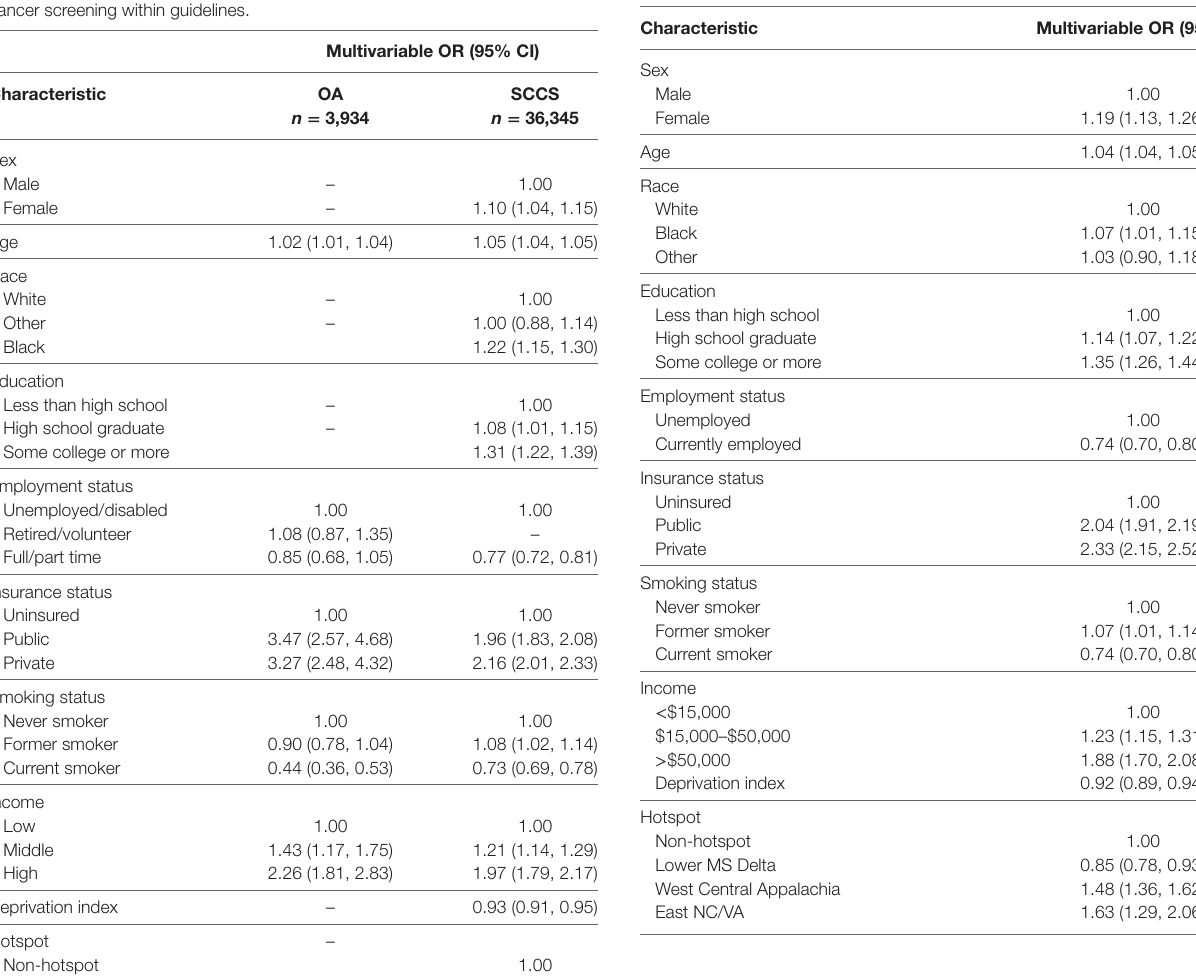
TaBle 3 | Southern Community Cohort Study multivariable multi-level logistic regression results for colonoscopy-only screening within guidelines.